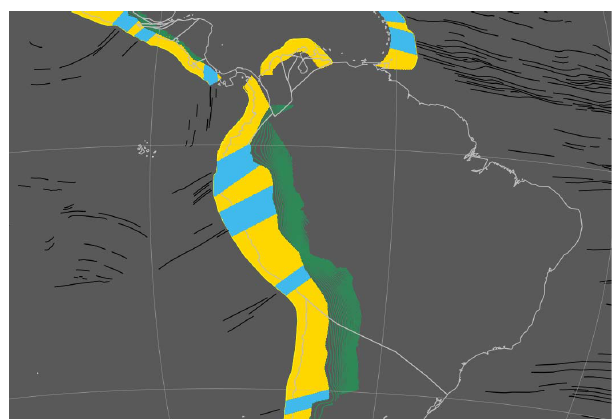
Fig. 7. Selected region in South America to demonstrate the defini- tion of fracture-zone subduction-zone regions of interest (filled blue regions), constrained by the underlying coupling zone (filled yellow regions). Green contours correspond to depth contours of the Slab 1.0 3-dimensional subduction model, with black lines defining frac- ture zones. Coastlines are shown for context (grey). The fracture- zone intersection regions are shown for a 100km buffer